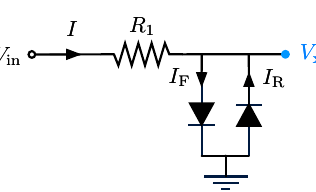
Figure 6. Equivalent view of the diode saturator at the non-inverting input of the op-amp in Figure